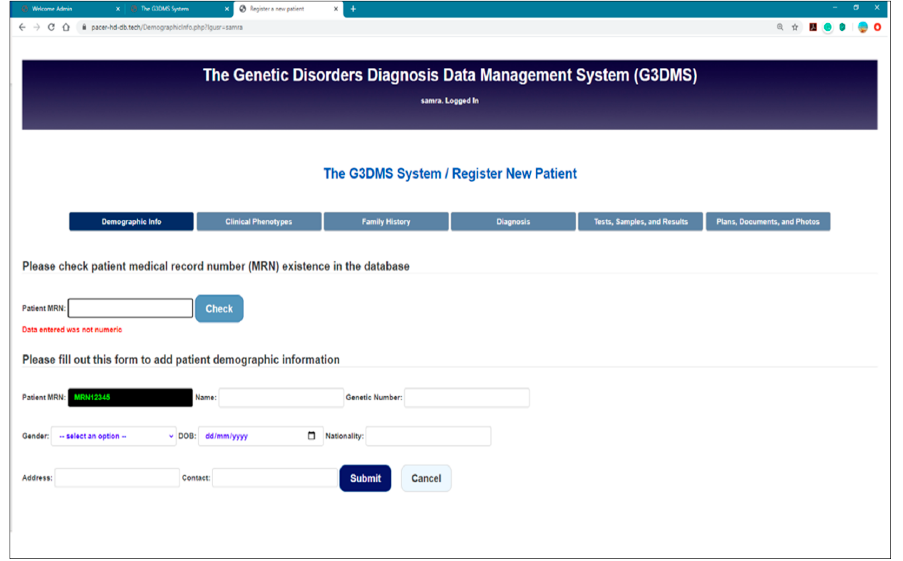
Figure 19. Field entry validation message.